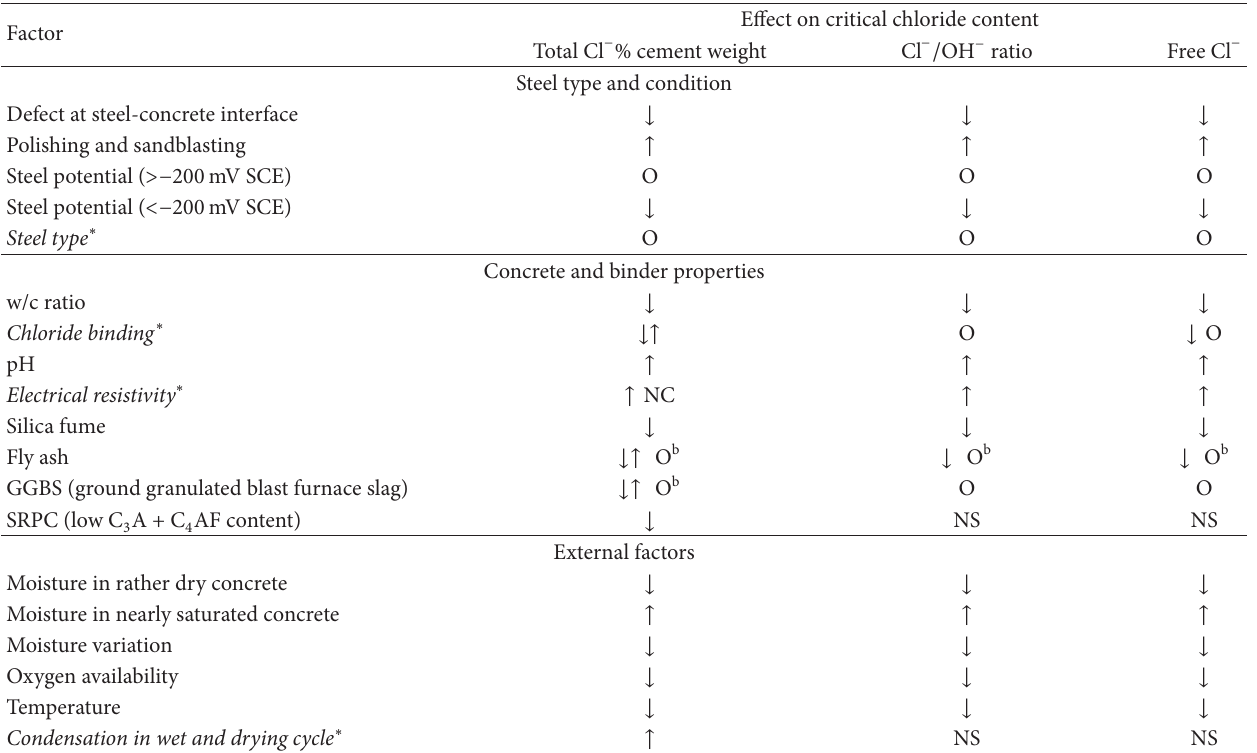
Table 2: Important factors and their effects on critical chloride